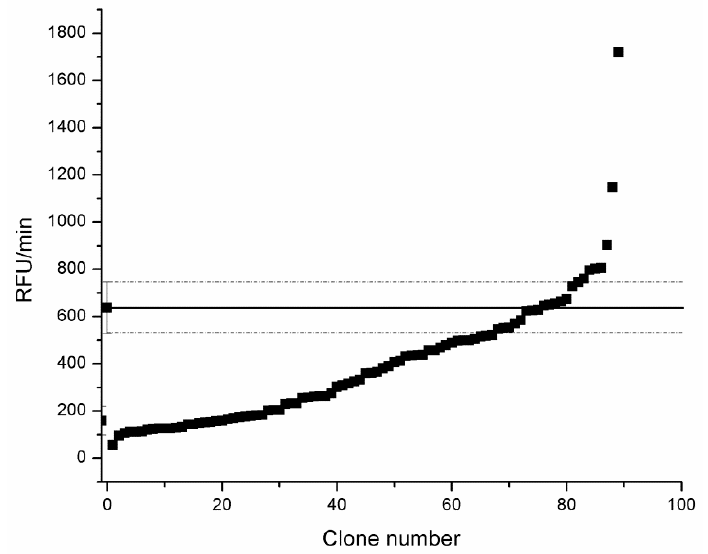
Figure 5. Screening of error prone tmCDH-pCTCON2 gene library in MTPs. Activity was measured in 0.1 M sodium phosphate buffer pH 5.5 with 0.1 mM resazurin and 10 mM lactose for 30 minutes. Relative fluorescence units (RFU)/min are at excitation/emission (ex/em) wavelengths of 540/590 nm. - ▪ - Parental gene activity (tmCDH).